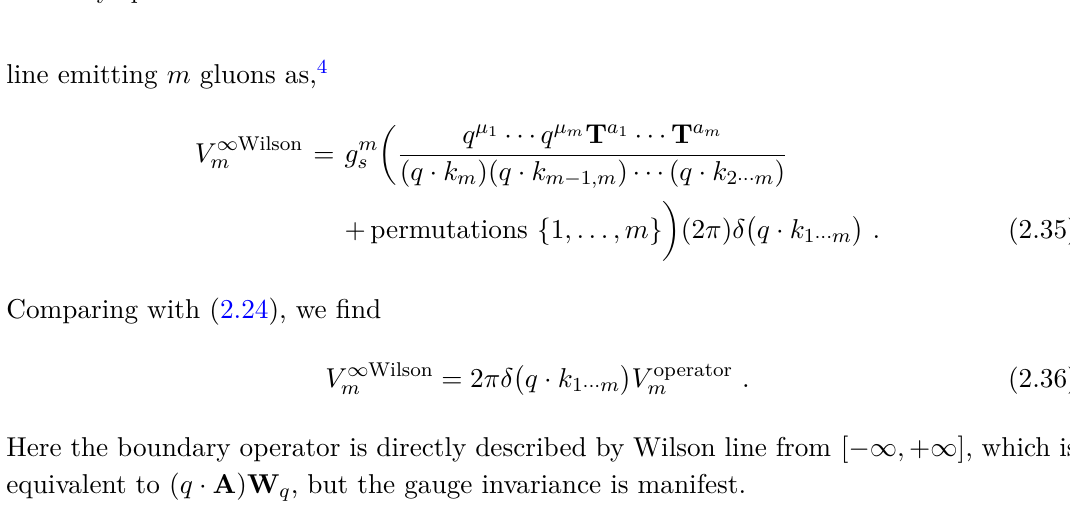
Figure 1 . Two Feynman diagrams contributing to the boundary contribution of four-gluon am- plitude under h g − | g + ] -shift. k 0 = − k 1 − k 2 . The crossed circle with a double-line represents the 3 4 boundary